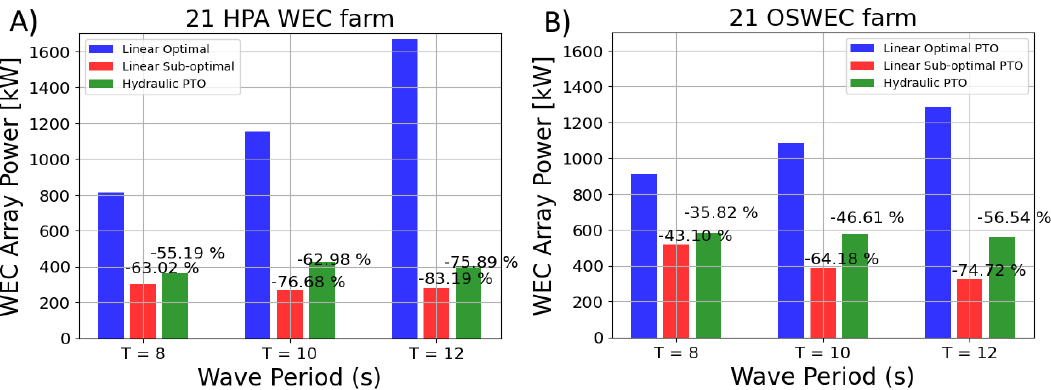
Figure 8. Bar charts showing the average power output for ( A ) a 21 HPA WEC farm (left) and ( B ) a 21 OSWEC farm (right) with a linear optimal PTO (blue, first bar), a linear sub-optimal PTO (red, second) and a hydraulic PTO (green, third bar). The percentage difference between the linear optimal PTO and the linear sub-optimal and hydraulic PTOs, respectively, is shown at the top of the